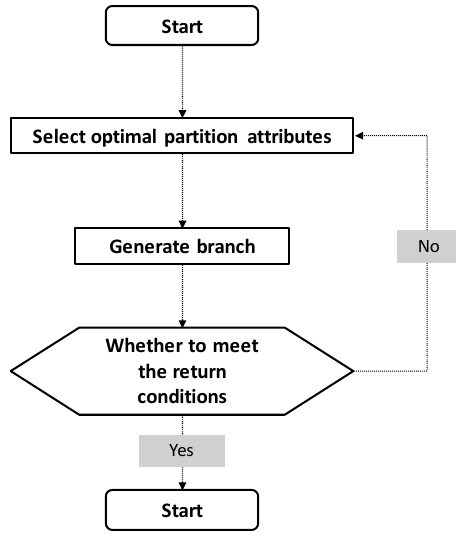
Figure 3. ID3 decision tree algorithm training steps.